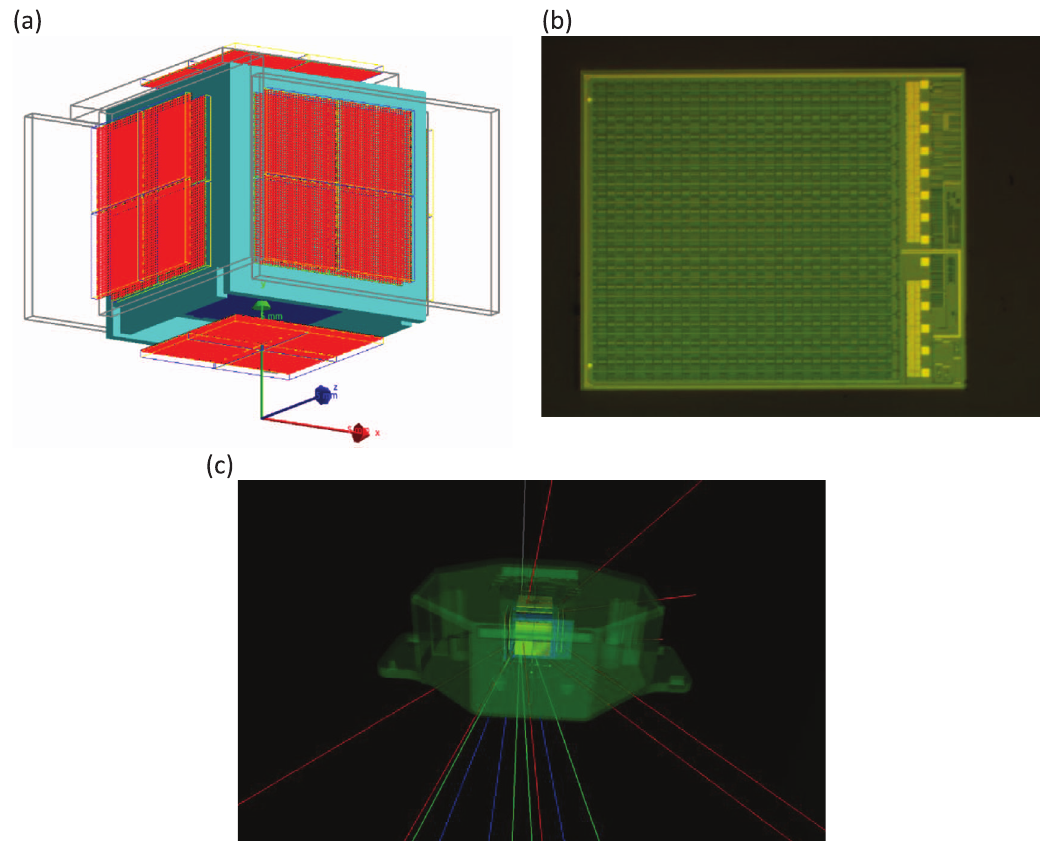
Fig. 1. (a) The geometry of the sensitive cube: two layers of Si pixel detectors are placed on each facet of a Ti box, which contains a plastic scintillator. At the bottom, a silicon photomultiplier in touch with the plastic scintillator and beneath them one layer of Si. (b) The die of the Si active pixel sensor. (c) Visualization of the tracks of secondary particles produced when a 10 GeV 56 Fe ion hits the device. Gray: the 56 Fe track; red: photon tracks; green: neutron tracks; blue: proton